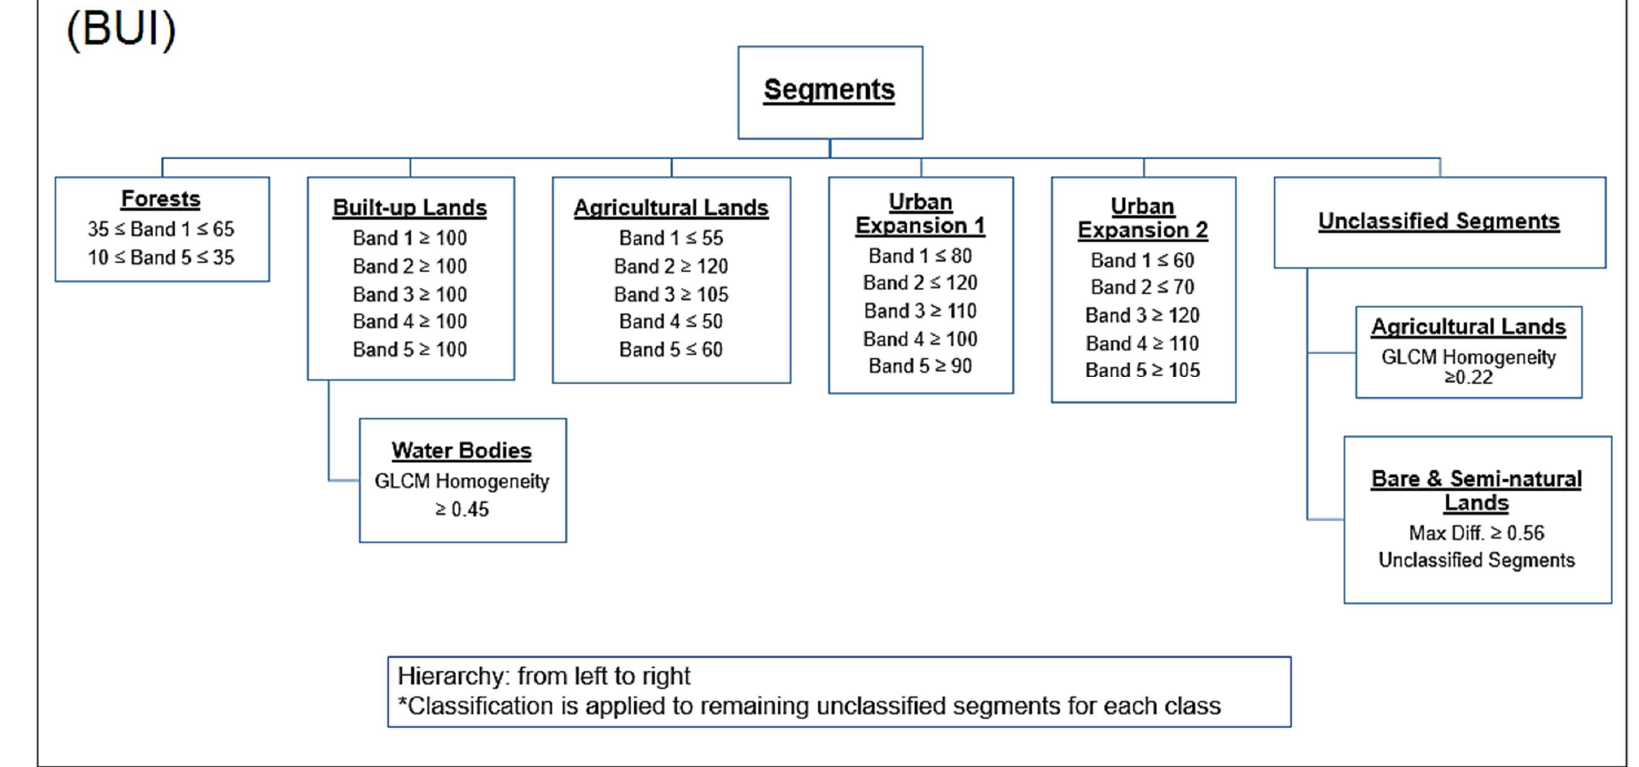
Figure A1. Threshold-based decision tree structure for the BUI dataset.